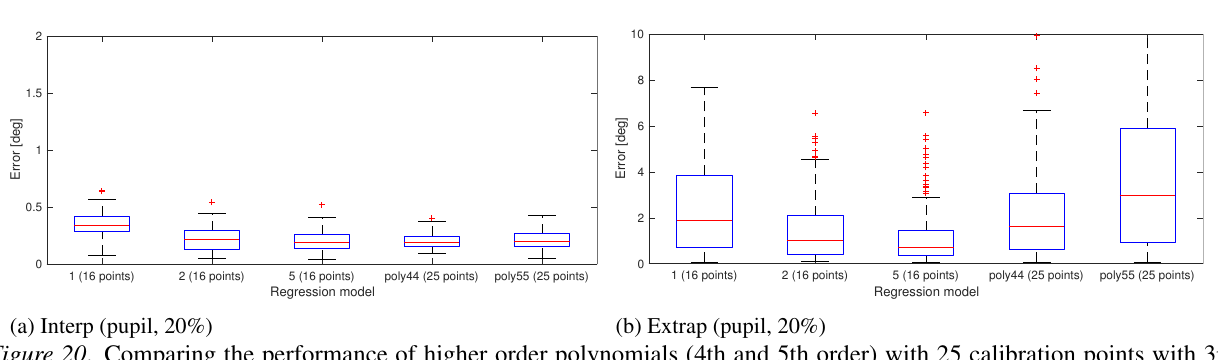
Figure 20 . Comparing the performance of higher order polynomials (4th and 5th order) with 25 calibration points with 3rd order polynomial models using 16 points for